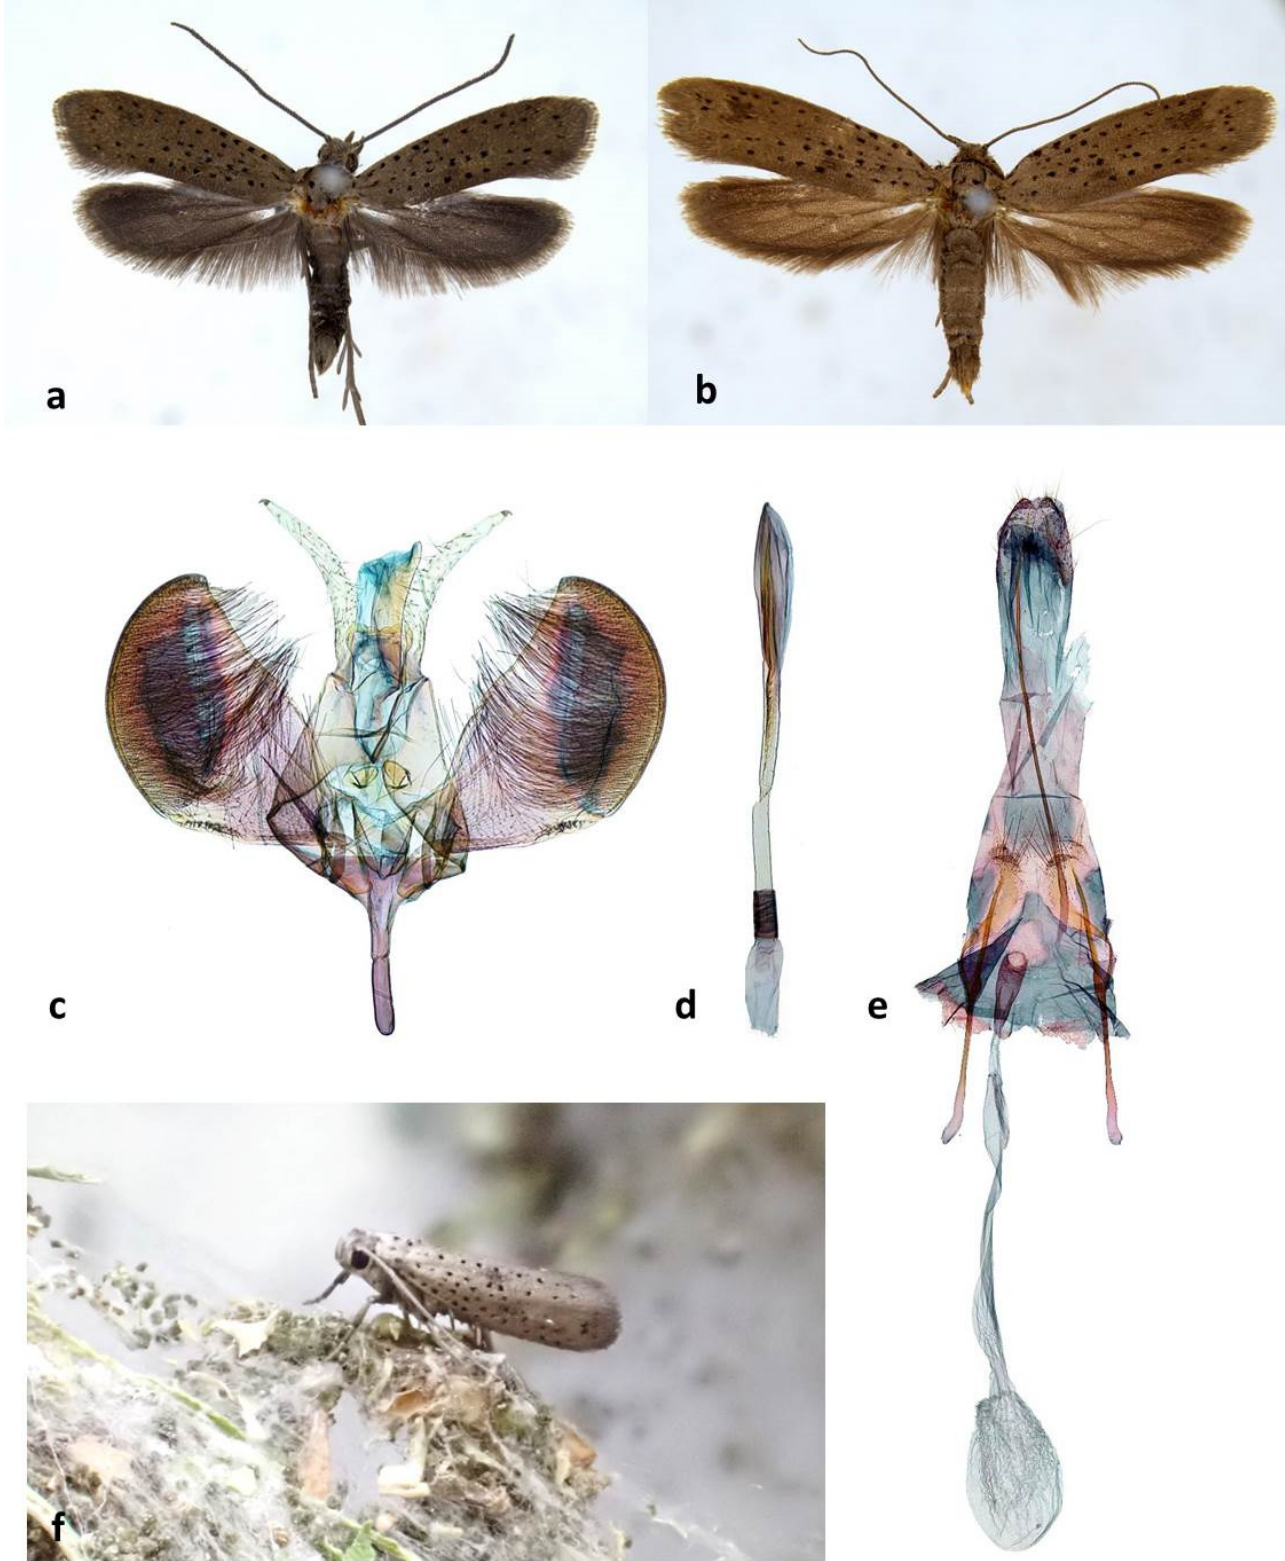
Figure 5. Adult of Yponomeuta meguronis : ( a , b ) dorsal view of adults; ( c ) male genitalia; ( d ) aedeagus; ( e ) female genitalia; and ( f ) newly emerged adult.